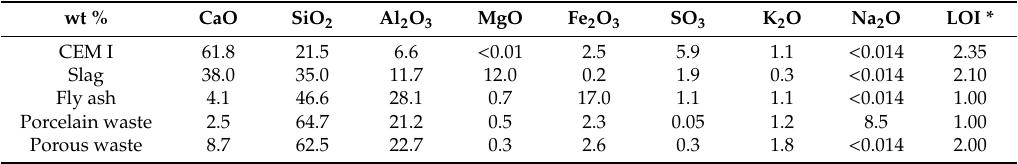
Table 1. Chemical composition by X-ray fluorescence.